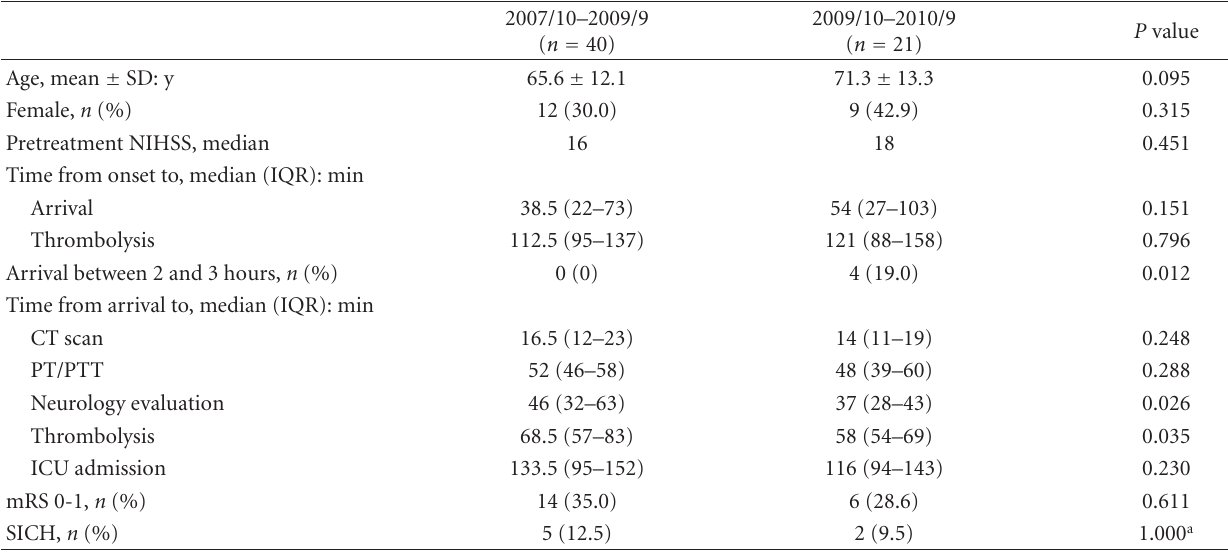
Table 2: Patients treated with thrombolytic